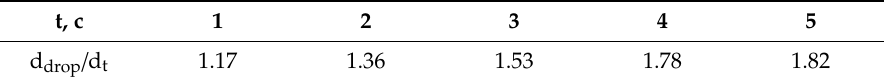
Table 1. The dependence of the size of the drop on the heating